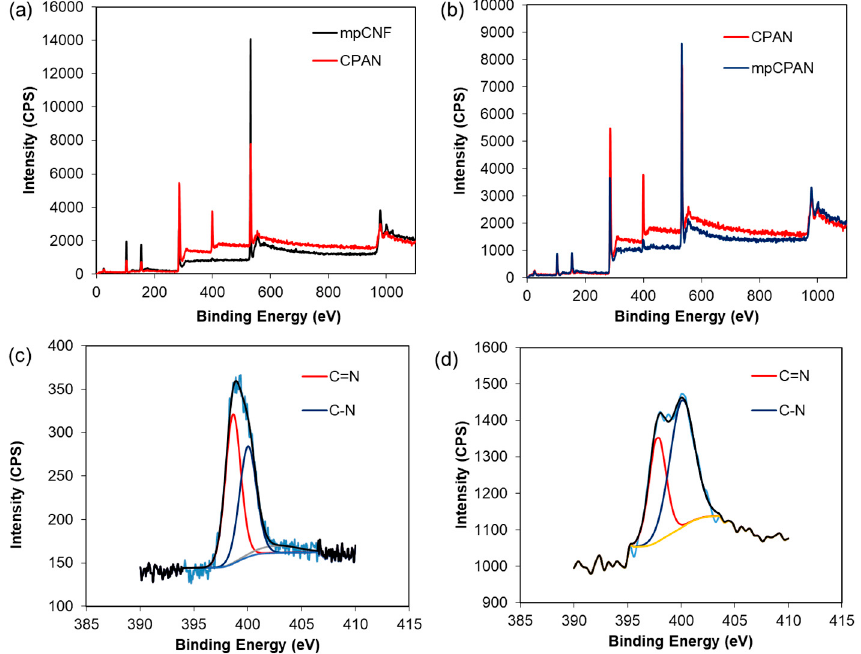
Figure 7. ( a ) XPS survey scanning spectra for mpCNF and CPAN; ( b ) XPS survey scanning spectra for mpCPAN and CPAN; ( c ) High Resolution N 1s spectra of CPAN; ( d ) High Resolution N 1s spectra of mpCPAN.